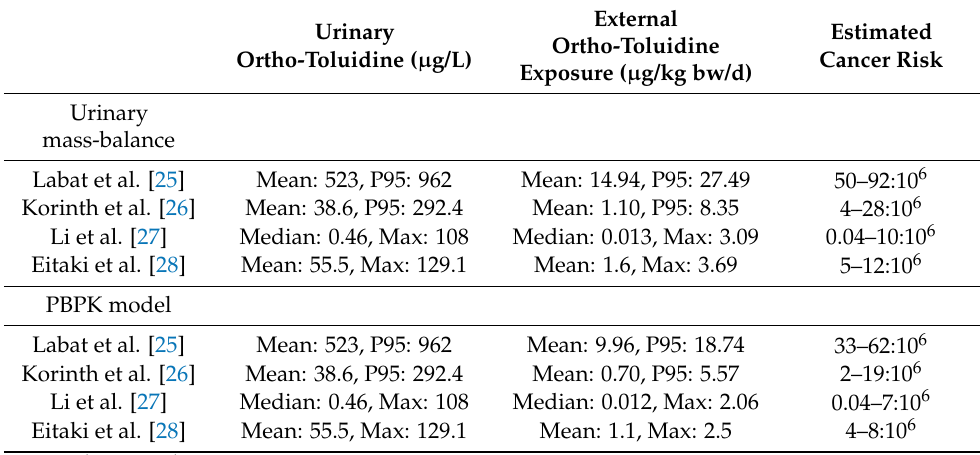
Table 5. Estimated occupational cancer risk values for o-toluidine using a urinary mass-balance method and a PBPK model in INTEGRA. External Estimated Urinary Ortho-Toluidine Cancer Risk Ortho-Toluidine ( µ g/L) Exposure ( µ g/kg bw/d) Urinary mass-balance Labat et al. [25]